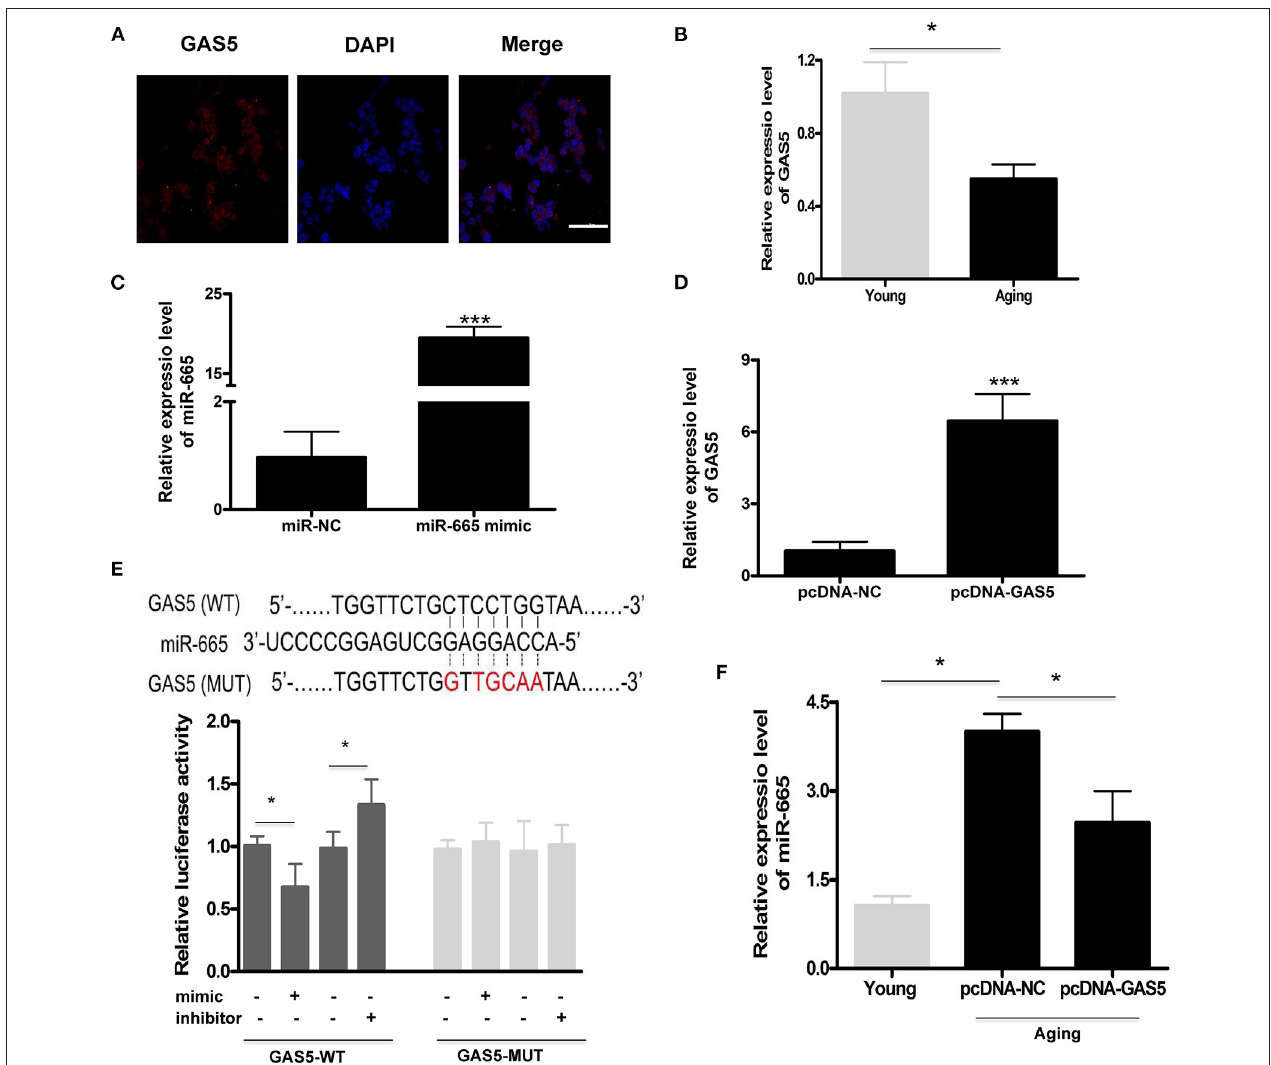
FIGURE 2 | LncRNA GAS5 acts as a molecular sponge to negatively regulate miR-665. (A) Representative subcellular fractionation of lncRNA GAS5. Scale bar indicates 20 µ m. (B) Representative average data of lncRNA GAS5 determined by qRT-PCR assays in young and aging VSMCs. * P < 0.05. (C) qRT-PCR-based determination of transfection efficiency of miR-665 in aging VSMCs. *** P < 0.001. (D) qRT-PCR-based measurement of transfection efficiency of lncRNA GAS5 in aging VSMCs. *** P < 0.001. (E) Representative predicted binding region of miR-665 and lncRNA GAS5, and relative luciferase activity determined by dual luciferase reporter assay. * P < 0.05. (F) Representative average data of miR-665 determined by qRT-PCR in young and aging VSMCs transfected with pcDNA-GAS5 and pcDNA-NC. * P <